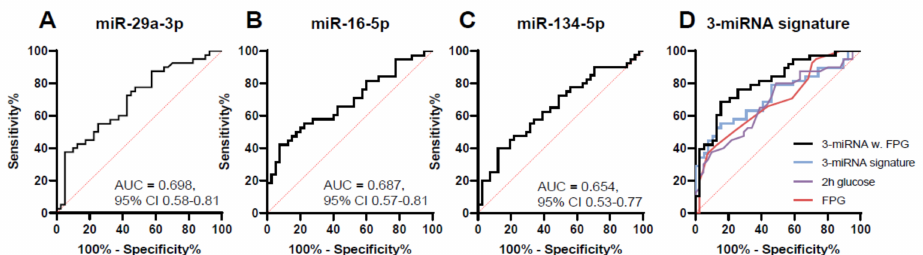
Figure 2. Predictive capabilities of circulating miRNAs. ROC curves based on miRNA levels. Shown are the three miRNAs distinguishing between GDM cases diagnosed later in pregnancy and NGT cases ( A – C ) as well as a combination of these miRNAs (( D ) 3-miRNA signature, miR-16-5p, -29a-3p and -134-5p, AUC = 0.717, 95% CI 0.60–0.83). Fasting plasma glucose (FPG, AUC = 0.687, 95% CI 0.57–0.80) and 2-h glucose value (2h glucose, AUC = 0.681, 95% CI 0.57–0.80) were evaluated alone or in combination with the 3-miRNA